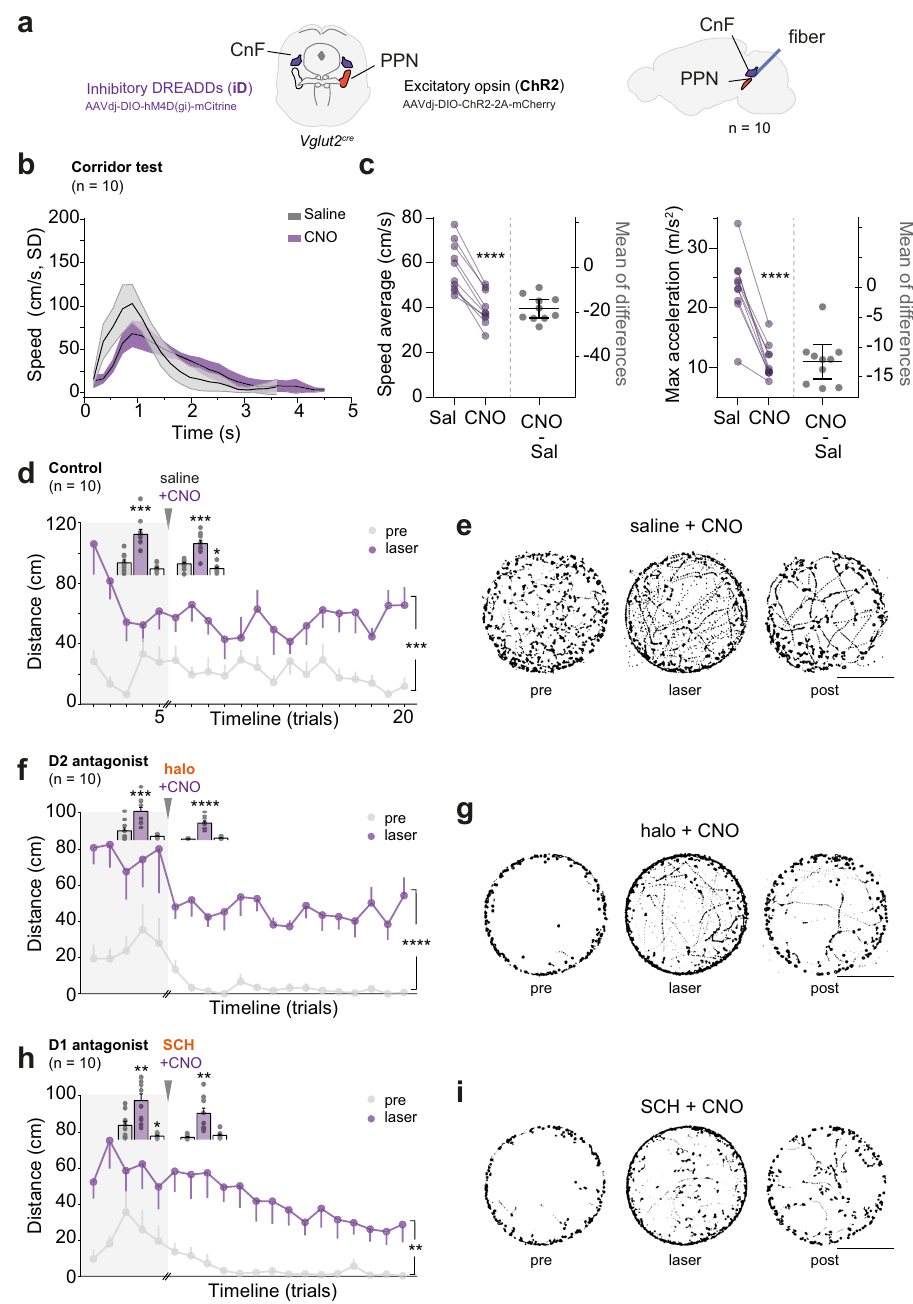
chemogenetic stimulation was that Vglut2-CnF mice performed long stop bouts (67.2% longer than saline-injected condition: two-tailed, paired t -test with p = 0.0270, t = 3.410, df = 4) (Fig. S6g) followed by abrupt changes to high-speed locomotion. This locomotor pattern resembles “ darting ” a behavior performed as a defense mechanism to avoid detection by predators 50 . Darting can effectively reduce the cumulative time needed to cover longer distances. A reliable approach to quantify darting in rodents comes from measuring, for each locomotor bout, the ratio between its Maximal Speed divided by its Duration, the so- called MSD ratio ([cm/s/s], see 50 for its origin). In WT rodents this ratio is around 25 cm/s/s 50 . The average MSD ratio of CNO injected Vglut2-CnF mice was 77 ± 10.6 cm/s/s [SD] and darting behavior occurred in nearly every locomotor bout (see individual